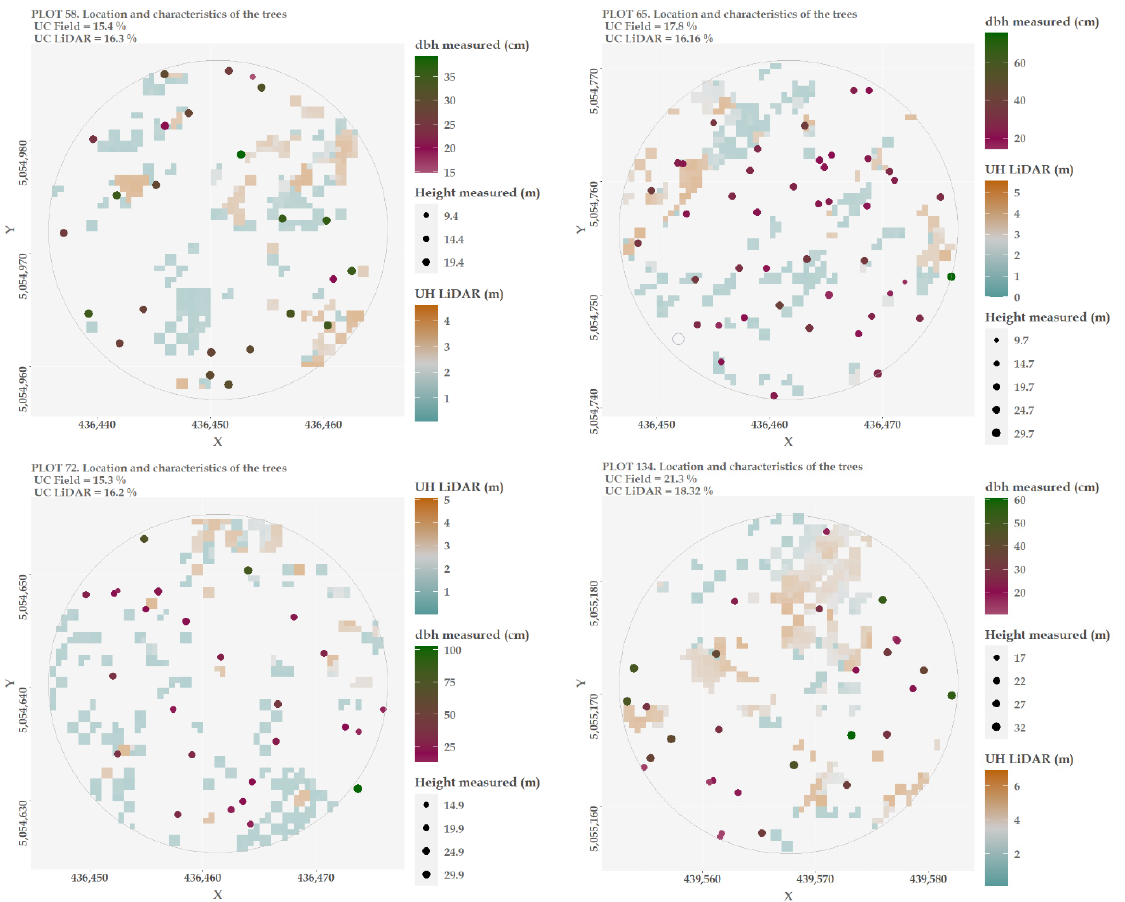
Figure A1 . Location and characteristics of the trees from field data and estimated LiDAR UC at the plot level.